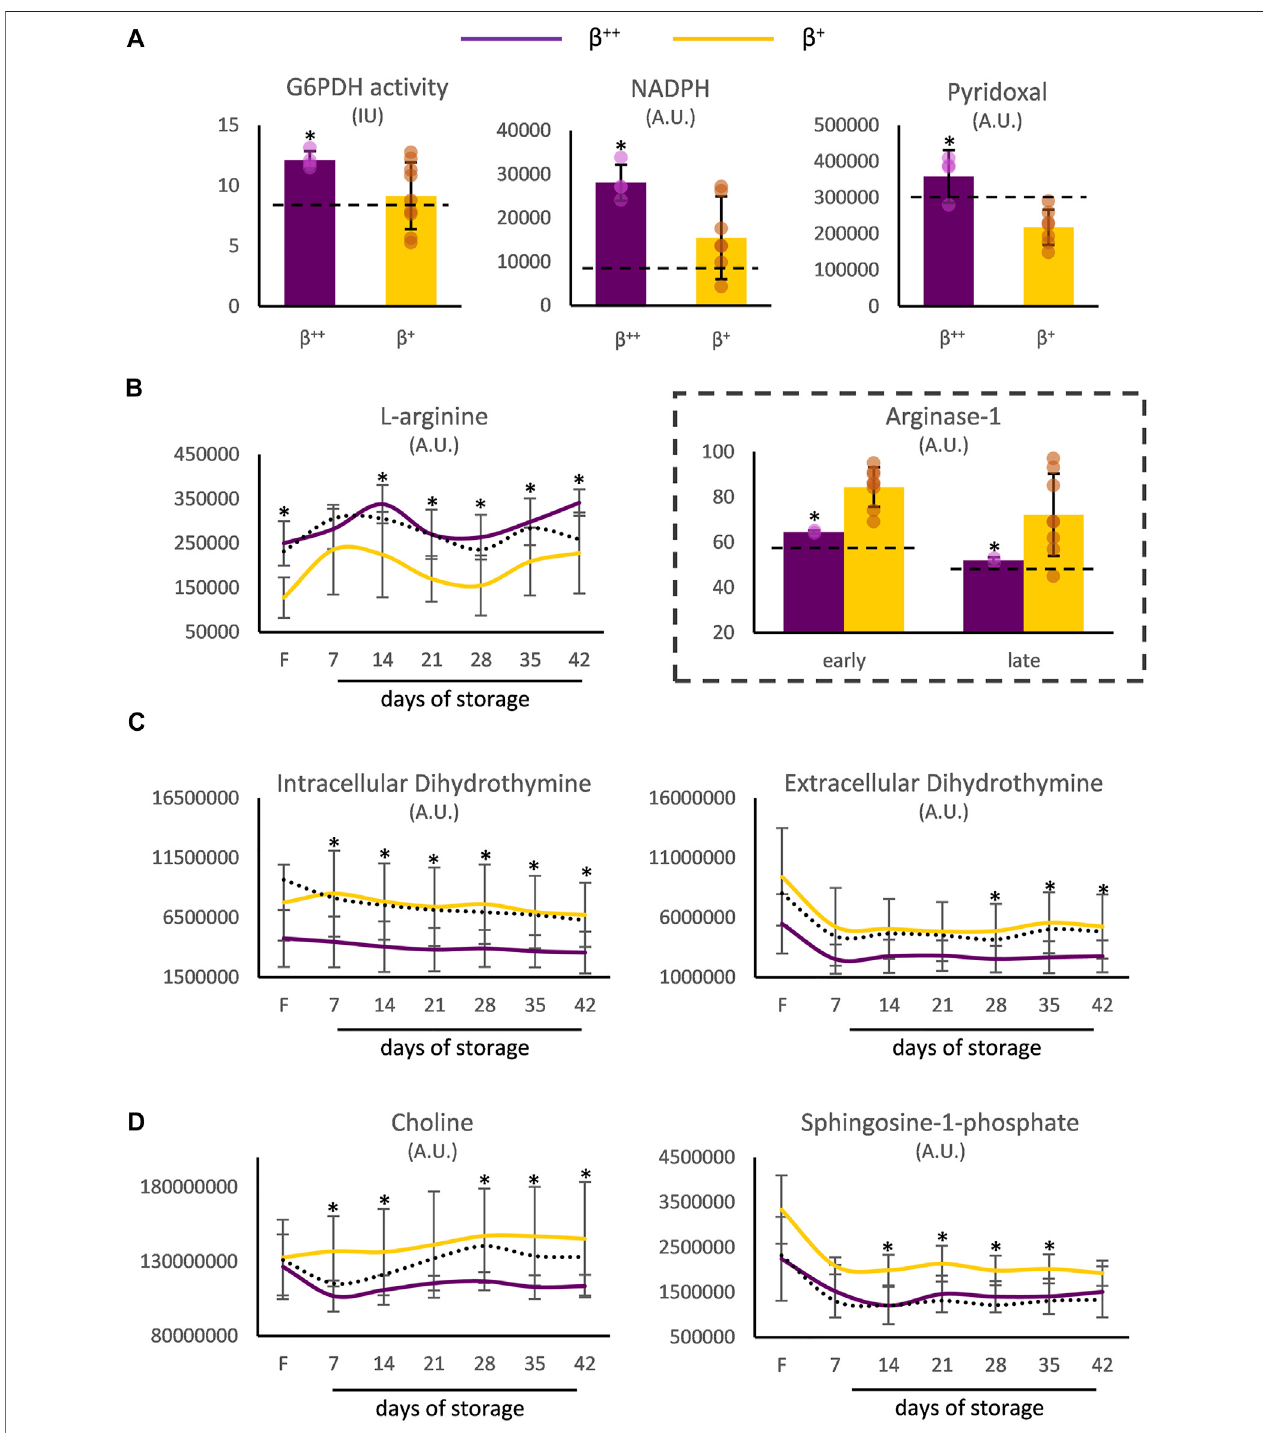
FIGURE3| Metabolismdifferencesbetween β ++ and β + heterozygotes. (A) Invivo differencesinreducingandantioxidant powers.Differencesinfreshlydrawnand stored red blood cells in (B) arginine, (C) dihydrothymine and (D) metabolites implicated in the biosynthesis of glycerophospholipids. Values for average controls are shown by dashed lines. Proteomic parameters are shown in dashed boxes ( n = 2 vs. 8, β ++ vs. β + ). (*) p < 0.05. F: freshly drawn blood; G6PDH: glucose-6-phosphate dehydrogenase; IU: international units; NADPH: nicotinamide adenine dinucleotide phosphate; A.U. arbitrary units.